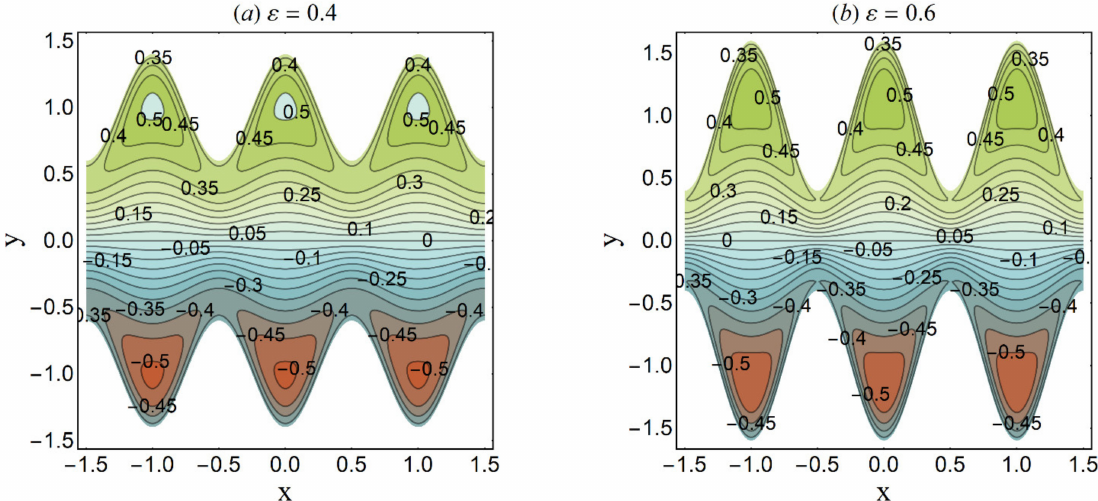
Figure 27. Streamlines for variation in ε when n = 0.2 We = 0.05, α = 0.45, Ha = 1, β = 0.1, U HS = 2, K = 2, Q = 0.4. ( a ) ε = 0.4; ( b ) ε =